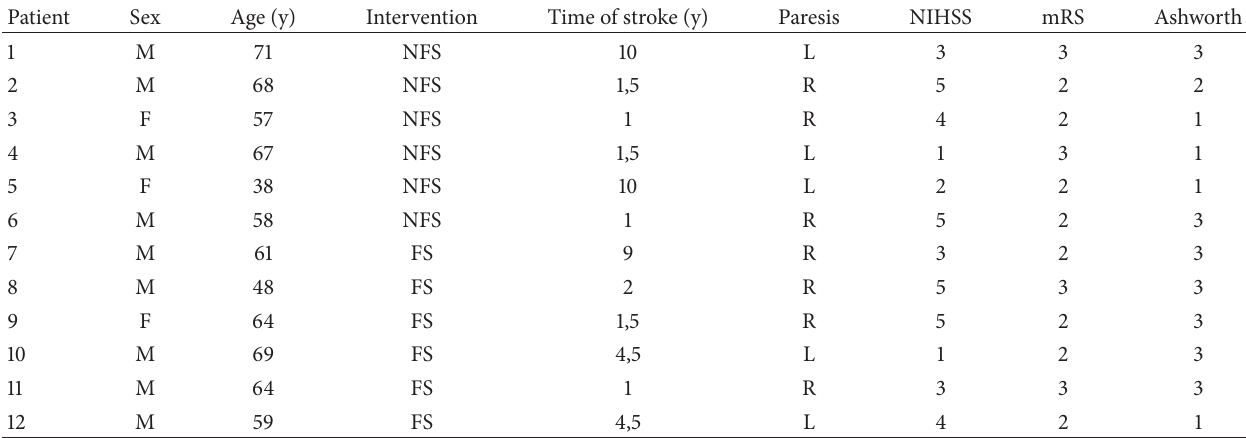
Table 1: Demographic data, training type (FS × NFS), and clinical characteristics (paresis, NIHSS, Rankin, and modified Ashworth scales) of all patients at P1 (baseline, before